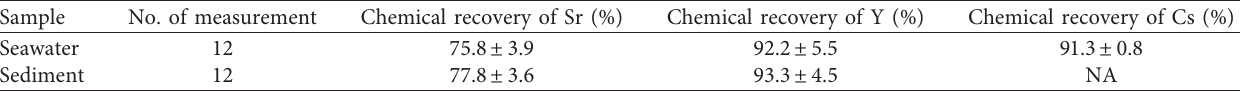
Table 3: Chemical recovery (mean ± SD) of Sr, Y, and Cs.